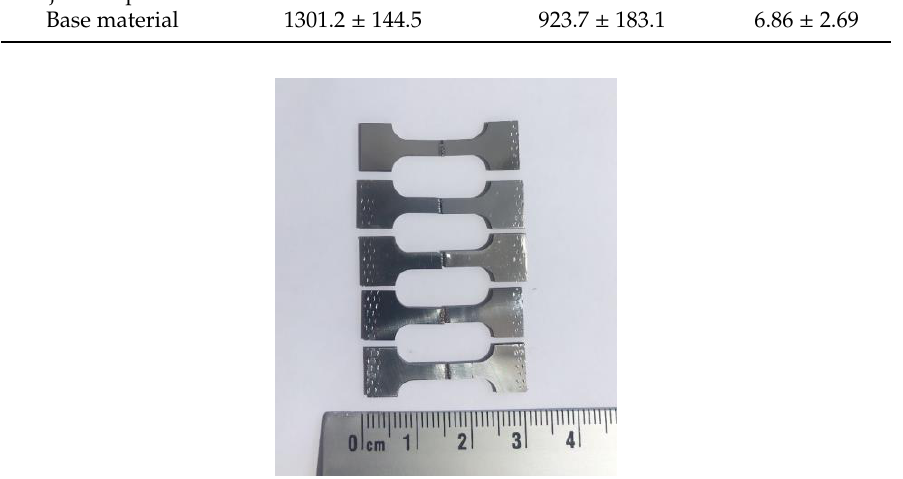
Figure 7. Fractured specimens after tensile testing.